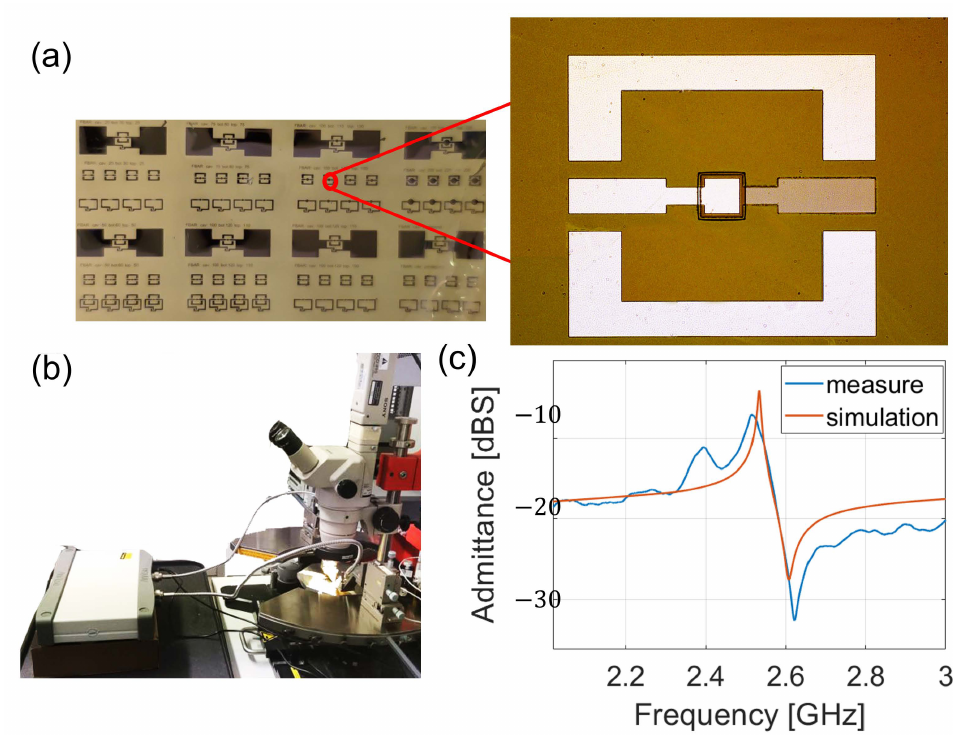
Figure 4. Characterisation of the FBAR. ( a ) Detached wafer and zoom on a resonator; ( b ) characteri- sation setup formed of VNA, probe station, and ground–signal–ground (GSG) probes; ( c ) comparison between simulations and